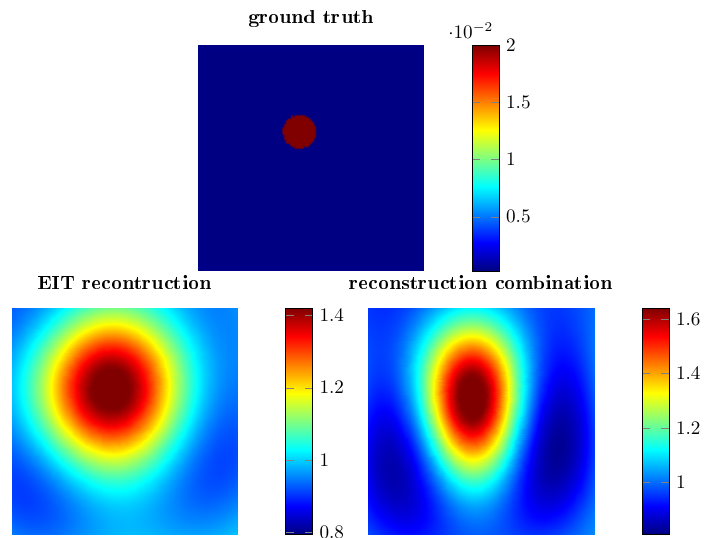
Figure 8. Top: Ground truth of the conductivity enclosure. Bottom left: EIT reconstruction with no noise added and R 1 = 3. Note: There is no a priori information in the image. Bottom right: Combined reconstruction with a priori information with a truncation radius R 2 = 4.